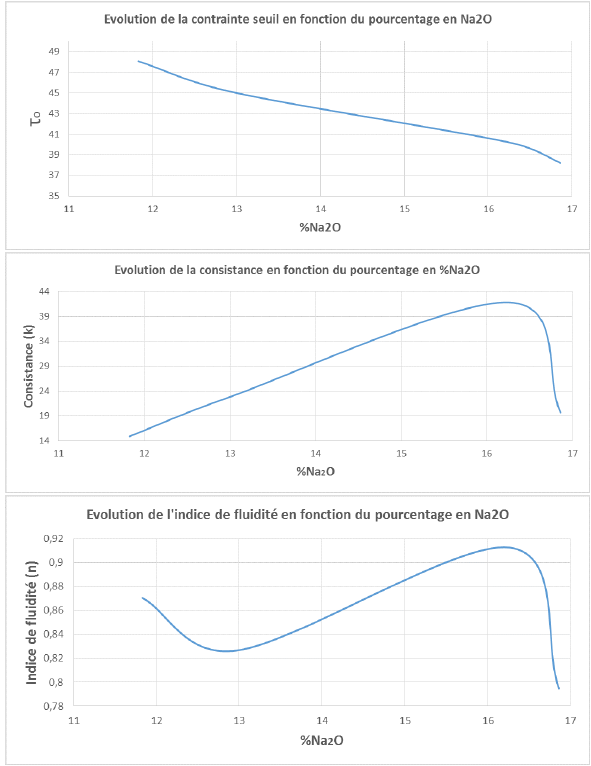
Figure 10: Effect of P on the rheological